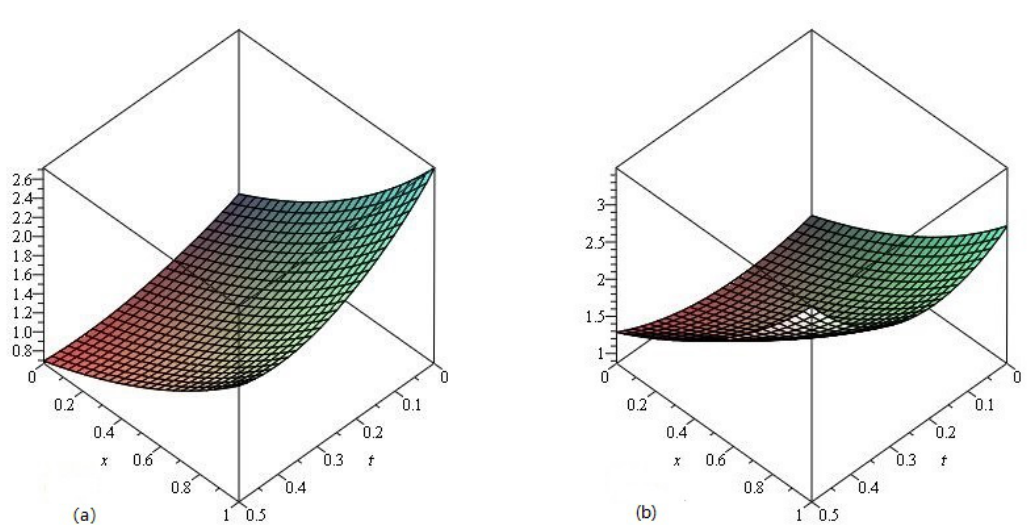
Figure 1. The ( a ) Exact and ( b ) LADM solutions of υ ( x , t ) of Example 1 at γ = 1.